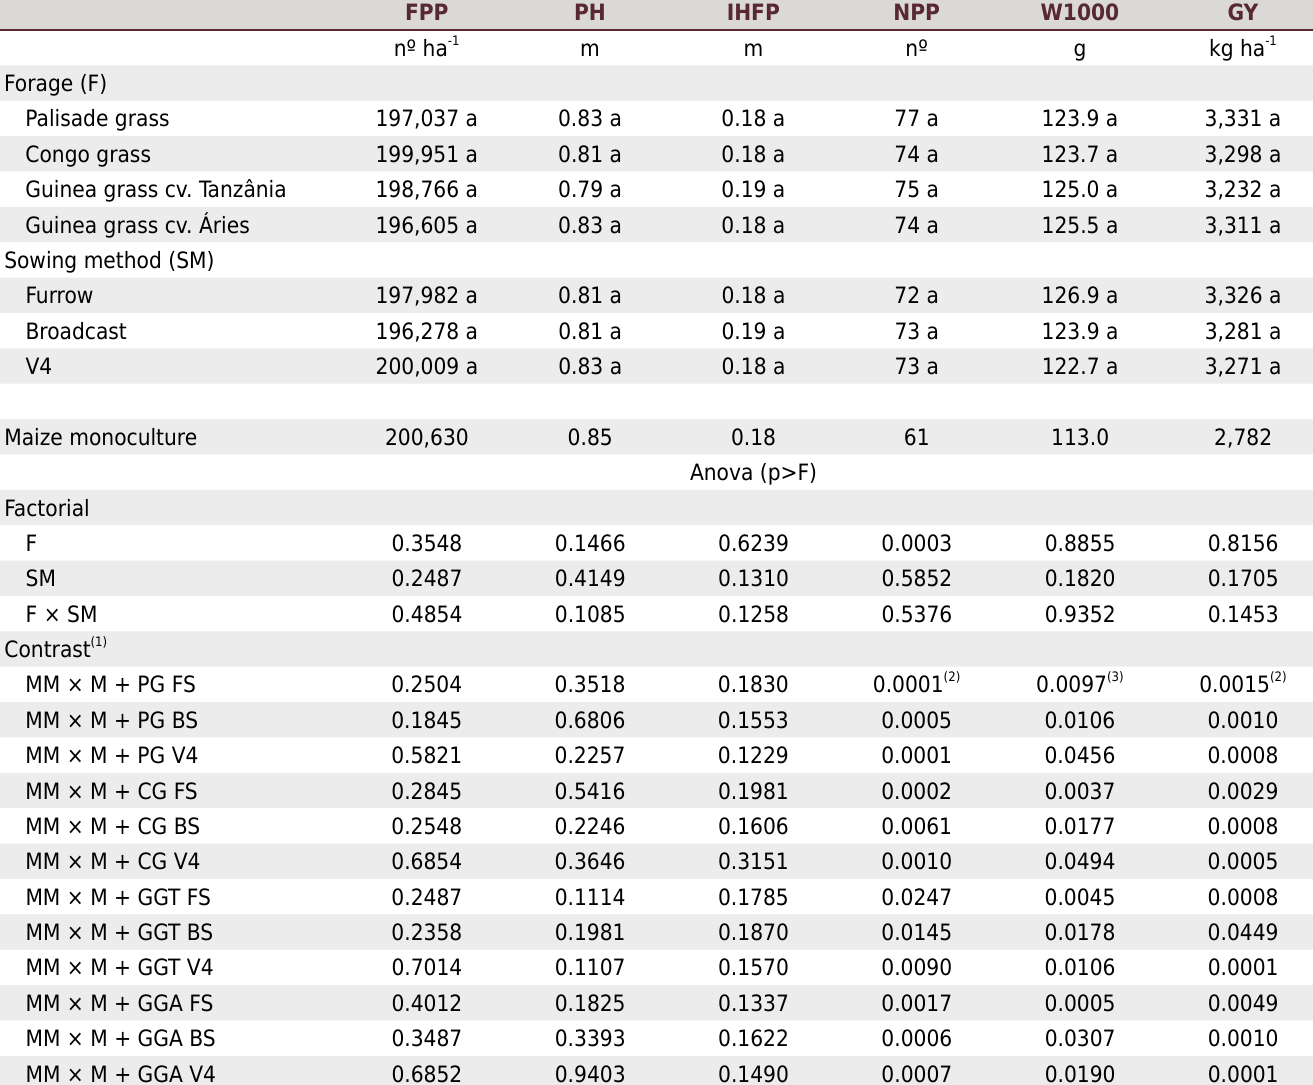
Table 3. Final plant population (FPP), plant height (PH), insertion height of first pod (IHFP), number of pods per plant (NPP), thousand grain weight (W1000) and grain yield (GY) of soybean after maize in monoculture or intercropped with forages sown in different methods and significance of ANOVA in factorial and contrast